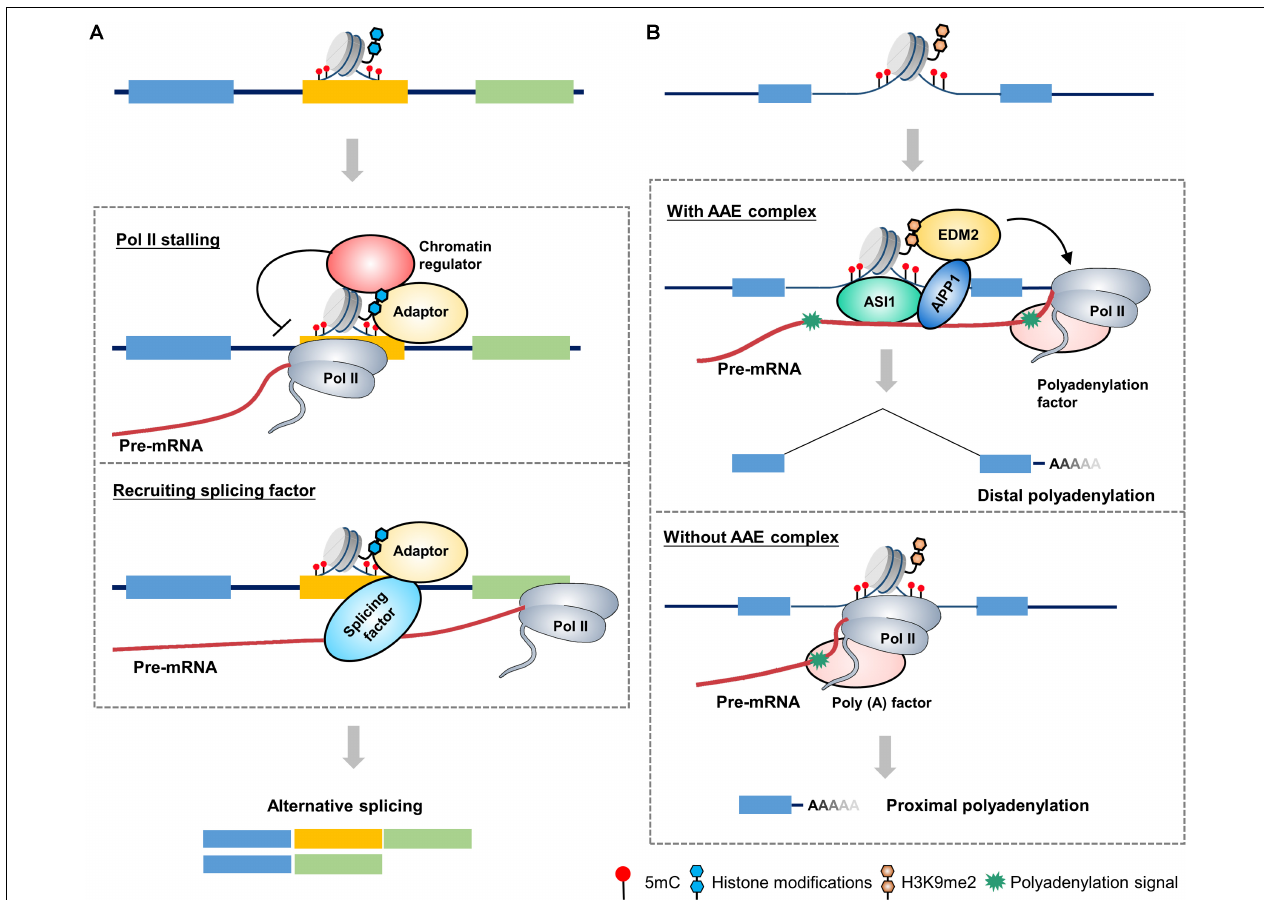
FIGURE 1 | A proposed model for chromatin-based epigenetic regulation of alternative RNA processing. (A) A proposed model of chromatin-based regulation of alternative splicing in mammals. Adaptor proteins recognizes and binds to alternative exon, which is marked by epigenetic marks (such as 5mC and histone modifications), to affect alternative splicing through two possible mechanisms: (1) Adaptor protein recruits chromatin regulators (such as chromatin remodelers, cohesion complex, etc.) to change the chromatin status of alternative exon, leading to a stalling of Pol II elongation, which in turn favors the retention of alternative exon. (2) Adaptor protein directly recruits splicing-related factors to promote the retention of alternative exon. (B) A proposed model of chromatin-based regulation of alternative polyadenylation in plants. The ASI1-AIPP1-EDM2 (AAE) complex recognizes and binds to the intronic heterochromatin elements (such as 5mC and H3K9me2) and corresponding pre-mRNA, favoring the passthrough of elongating Pol II, thereby promoting the usage of distal polyadenylation signal. When the AAE complex is absent, Pol II elongation is slowed down at intronic heterochromatin region, which favors the usage of proximal polyadenylation signal. Different colored boxes in (A) and (B) represent